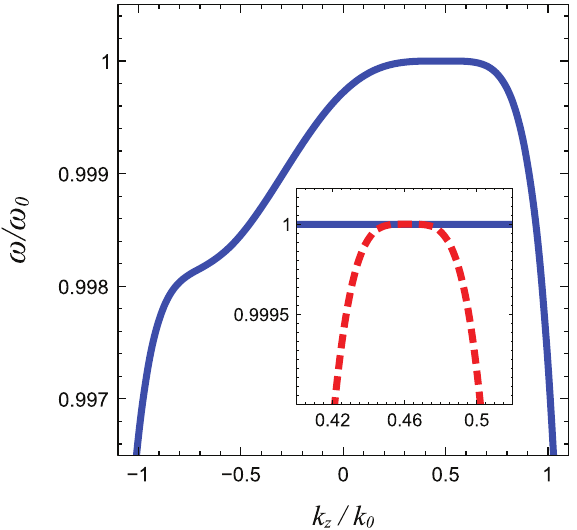
Figure 3. Numerically-computed dispersion diagram (blue-solid curve) for the synthesized multilayered metamaterial (with param- eters as in Figure 2 caption), for k x = 0 in the vicinity of the design angular frequency x 0 . The inset shows a magnified view around the DBE stationary point, compared with the blueprint prediction (red- dashed curve).